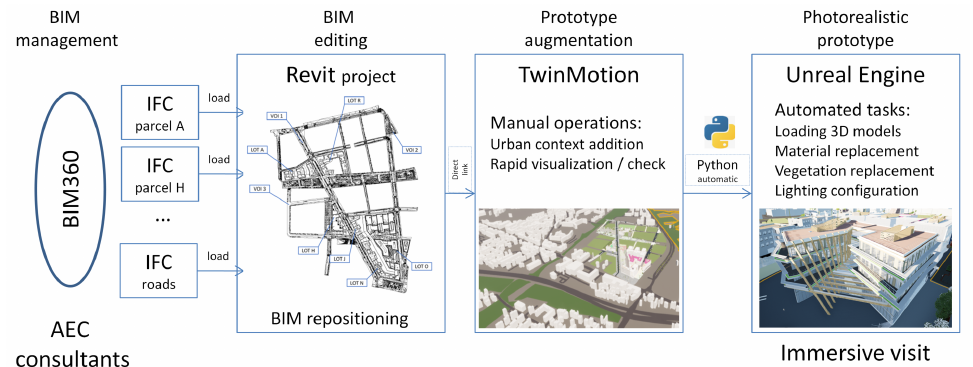
Figure 4. Immersive visit design: workflow diagram from AEC artwork data to virtual reality